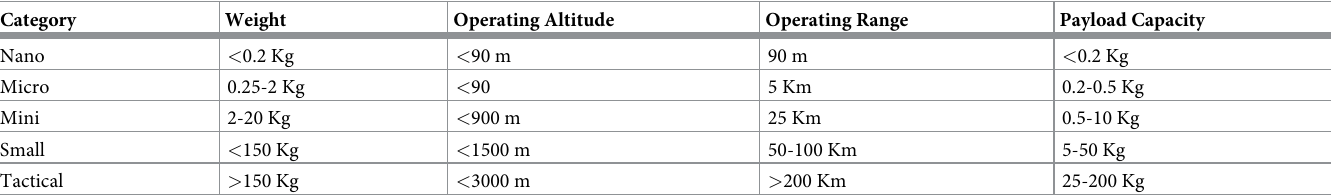
Table 1. Classification of drones